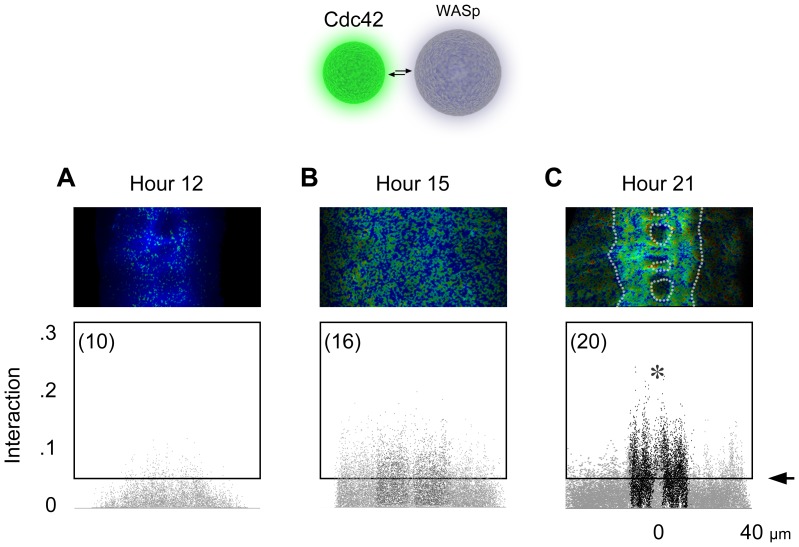
Cdc42-to-WASp interaction.A–C. Interaction between Cdc42 and WASp before (A), at the onset of (B), and after the formation of neuropil (C). Arrow points to the threshold based on background fluorescence.